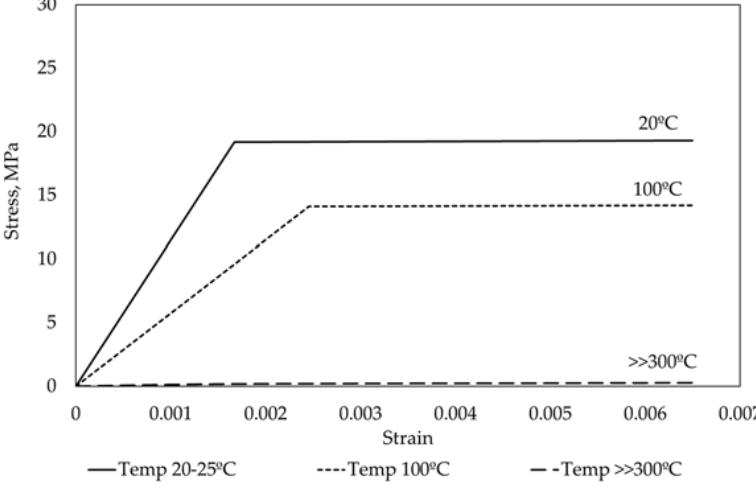
Figure 4. Strain–stress of GL24H wood at elevated temperatures.